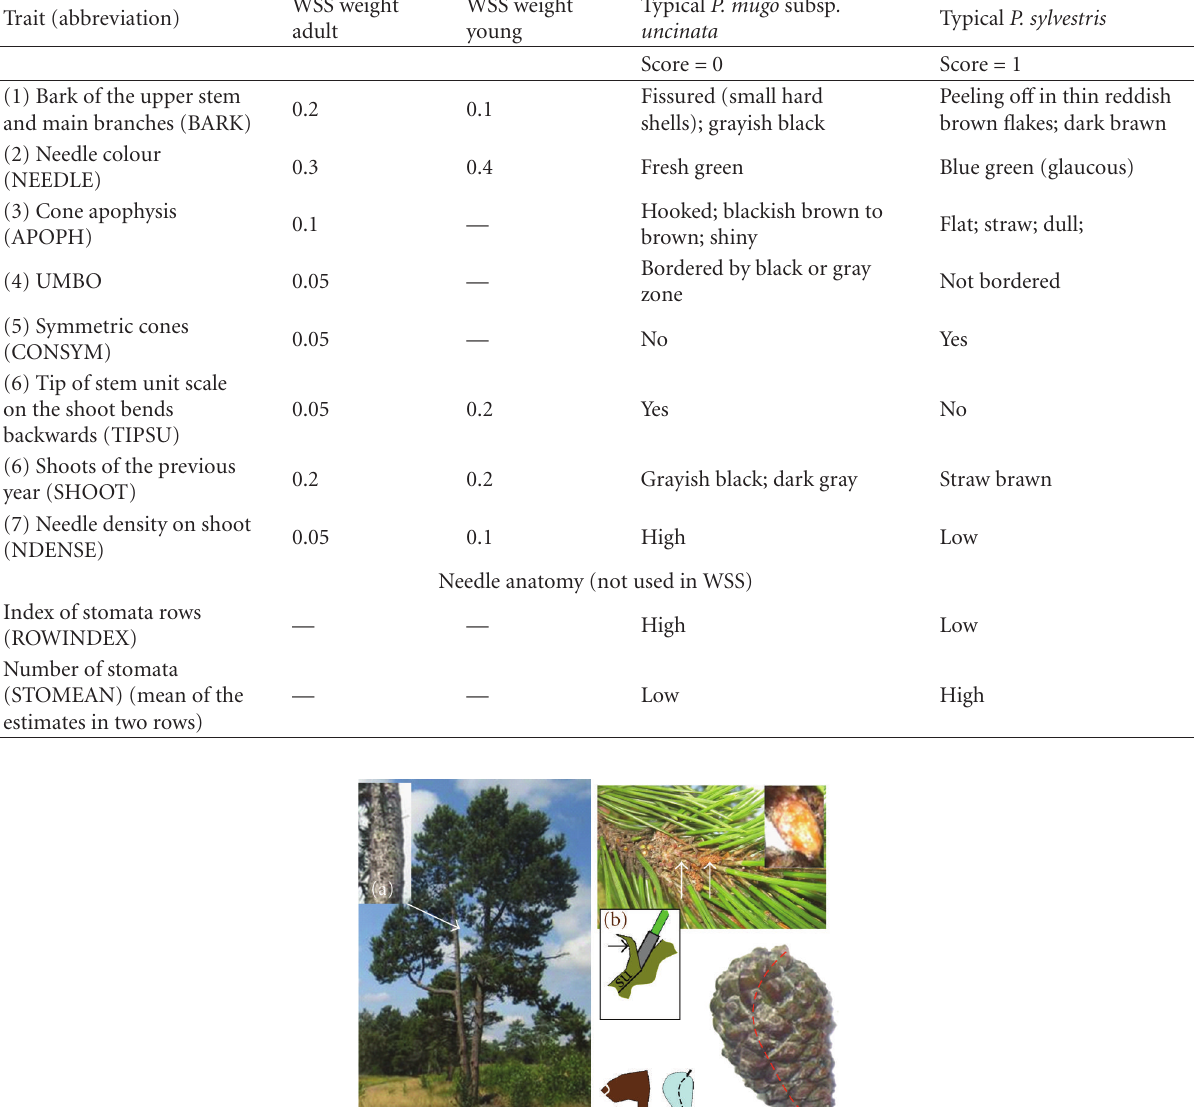
Table 2: Key-traits separating P. mugo spp . uncinata and P. sylvestris . An intermediate value of a trait was scored as 0.5. The weights were used in calculating of weighted score sum (WSS).